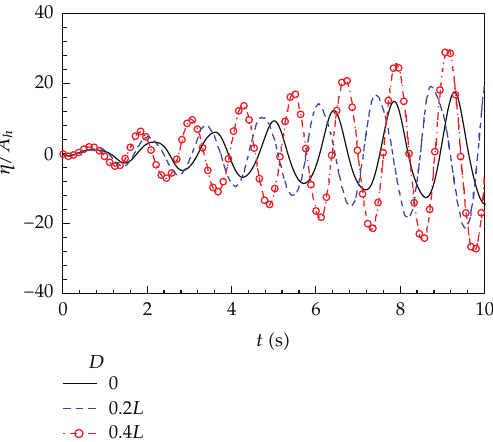
Figure 17: Time history of wave surface at left tank wall under the excitation of natural frequency.